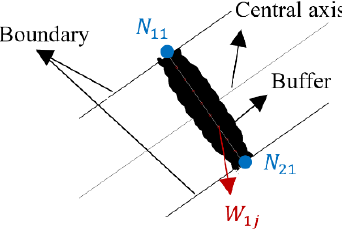
Figure 3 Construction of section